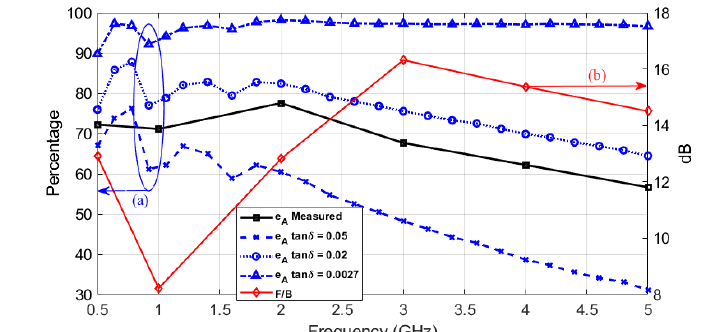
Figure 8. ( a ) Measured and simulated antenna efficiency e A versus frequency (in percentage) where the loss tangent of the substrate in simulations is set to: 0.05, 0.02 and 0.0027. ( b ) Measured front-to-back ratio (F/B) in dB versus frequency.